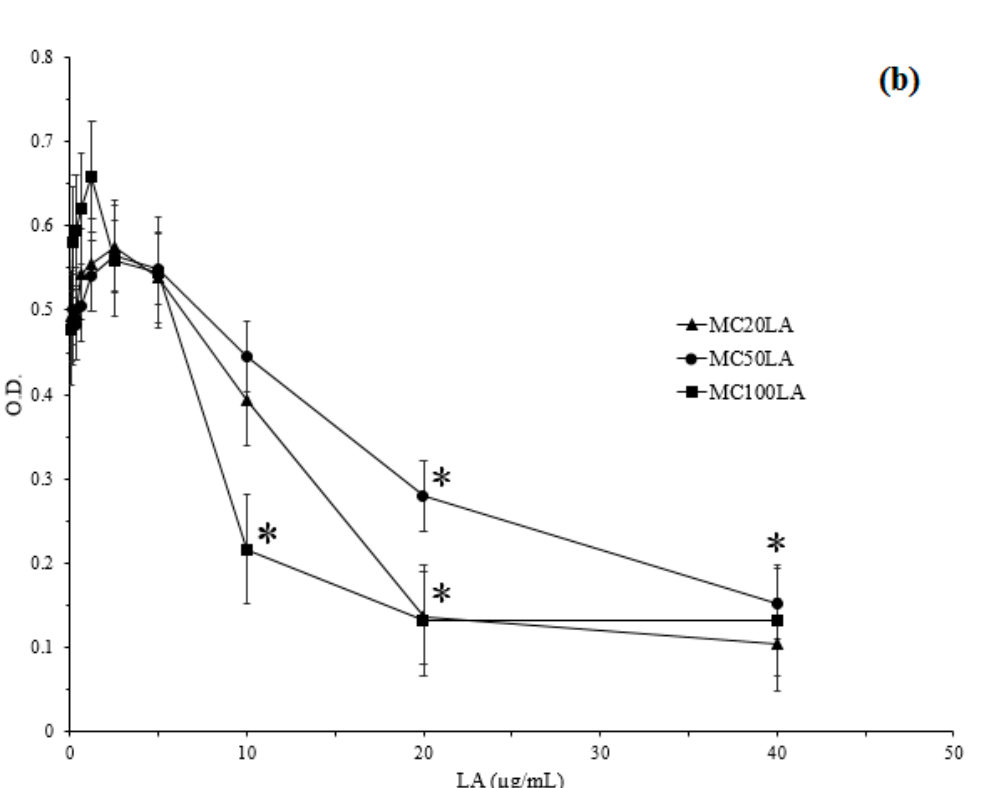
Figure 6. The minimum inhibitory concentration (MIC) assay. ( a ) MIC of free LA (in 5% DMSO); ( b ) MICs of MC 20 LA, MC 50 LA, and MC 10 LA. The initial concentration of bacteria was 10 6 CFU/mL; the optical density of bacteria at 600 nm was measured by ELISA. * indicates significant difference compared with a PBS control by student’s t -test ( n = 3).